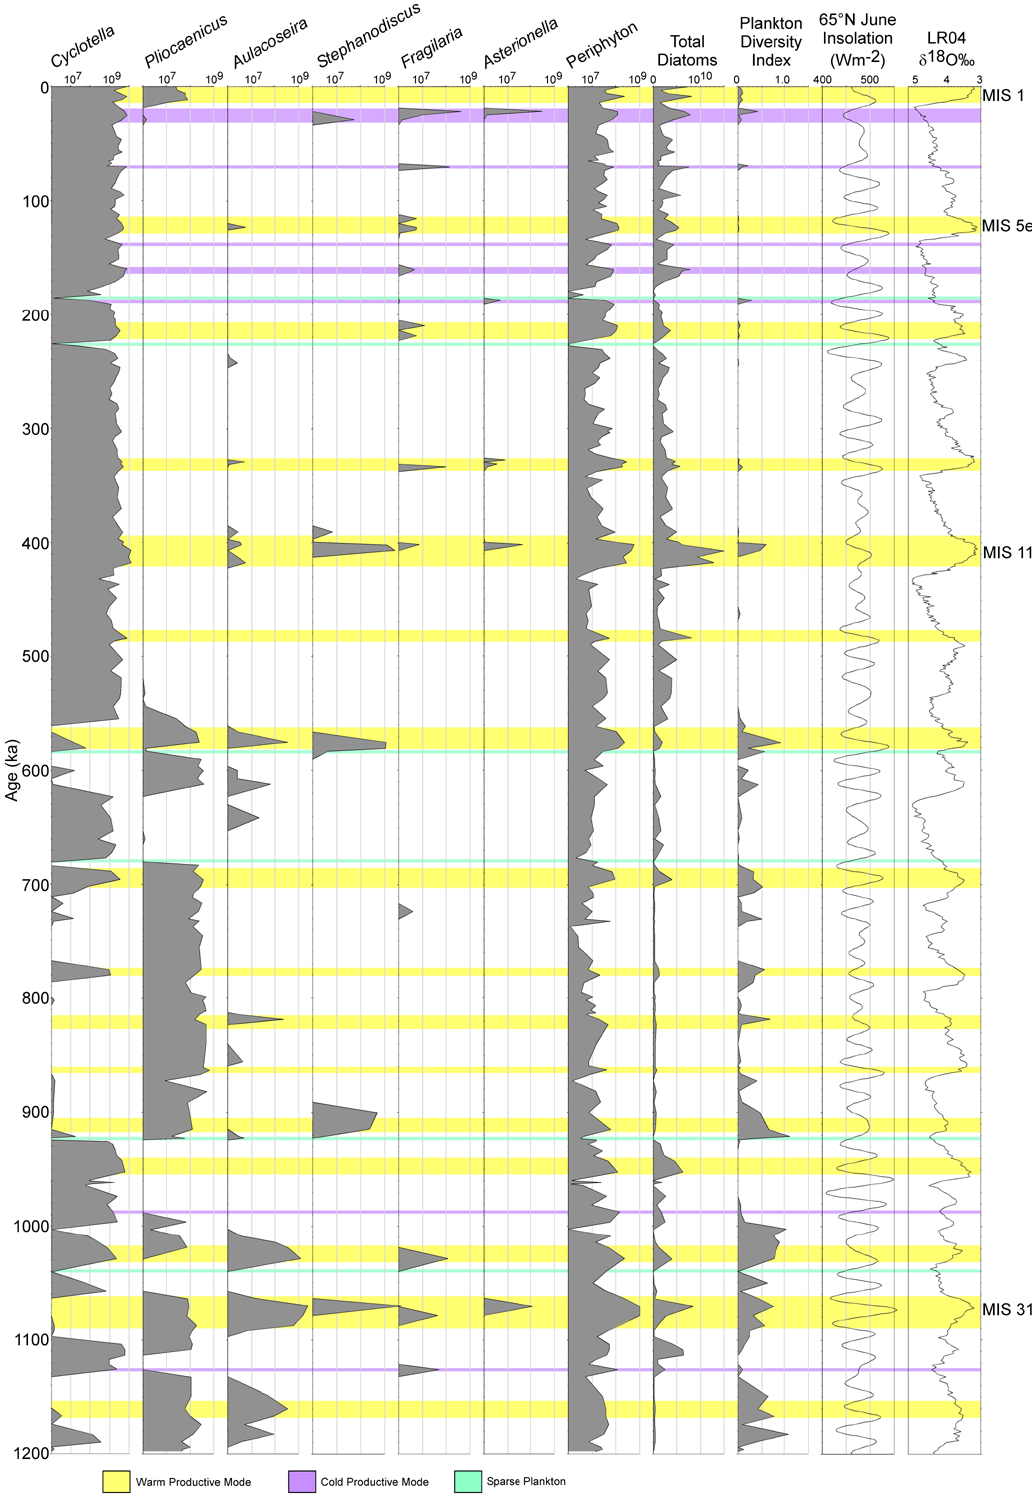
Fig. 2. Concentration (valves g − 1 ) of planktonic species, total periphyton, total diatoms, and plankton diversity (Shannon index) from 0 to 1.2Ma. Exceptional events are indicated by colored intervals. Diatom concentrations, except total diatoms, are plotted on a log scale. For comparison, the marine isotope stack (Lisiecki and Raymo, 2005) and 65 ◦ N June insolation (Laskar et al., 2004) are also